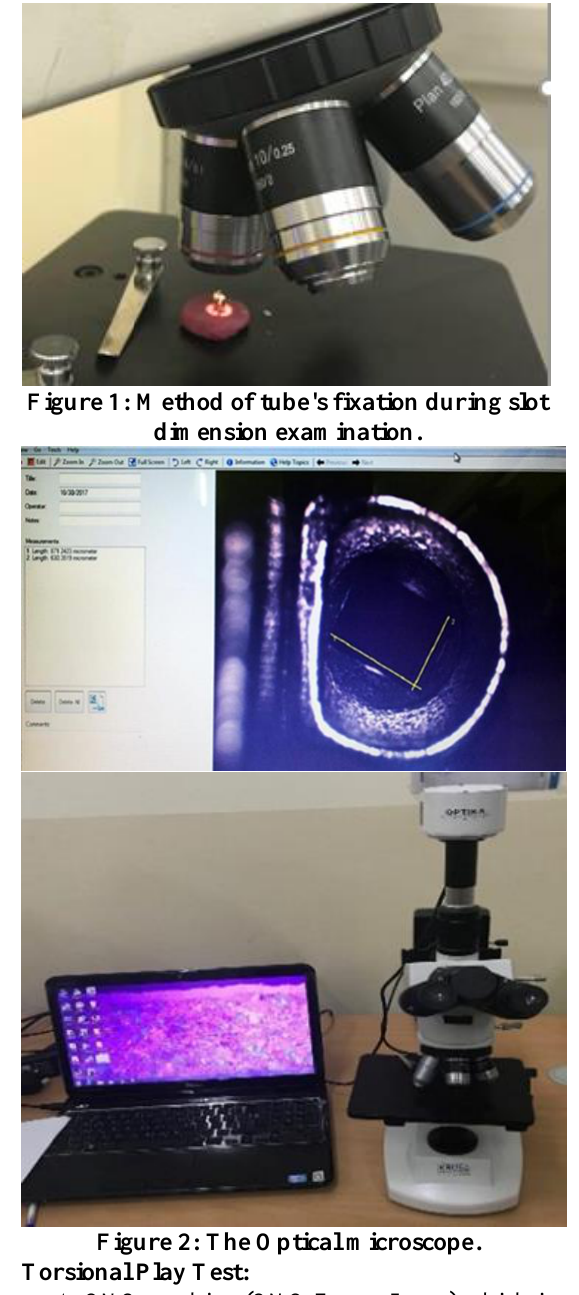
Figure 2: The Optical